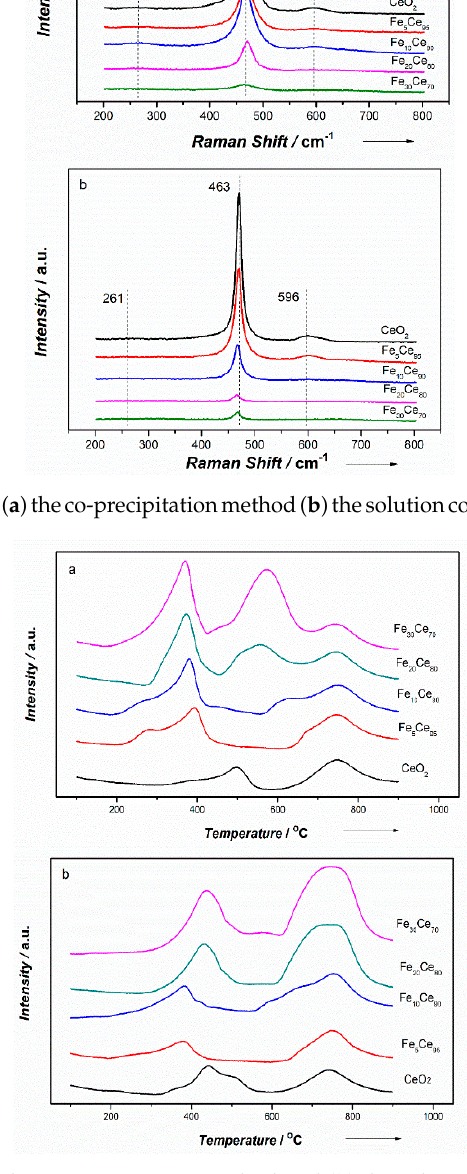
Figure 7. H 2 -TPR results of ( a ) the co-precipitation method and ( b ) the solution combustion synthesis